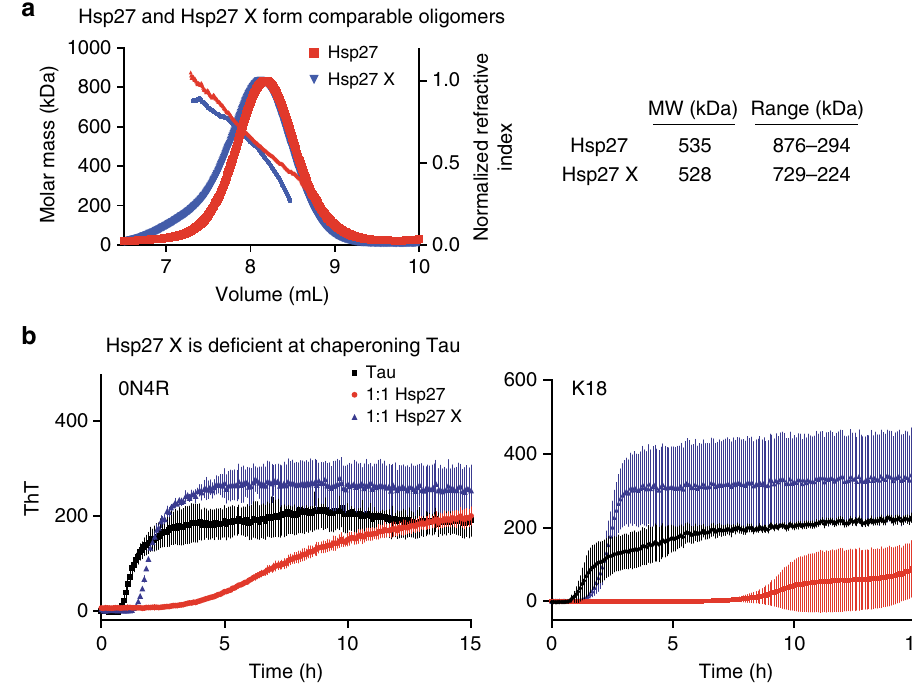
Fig. 5 Dynamics of Hsp27 are critical to limit tau aggregation. a SEC-MALS trace of Hsp27 and Hsp27X (40 µ M). b Representative aggregation curves of 0N4R (left) or K18 (right) Tau in the presence of 1:1 molar ratio of Hsp27 and Hsp27X (10 μ M). Results are representative of experiments performed in at least four independent replicates. Each individual experiment was performed in triplicate and the error bars represent SEM